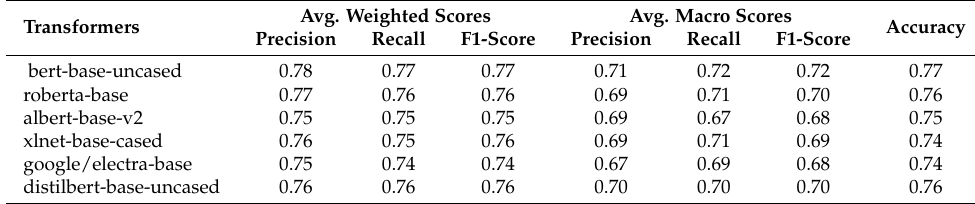
Table 6. Results of hope speech detection using transformers.